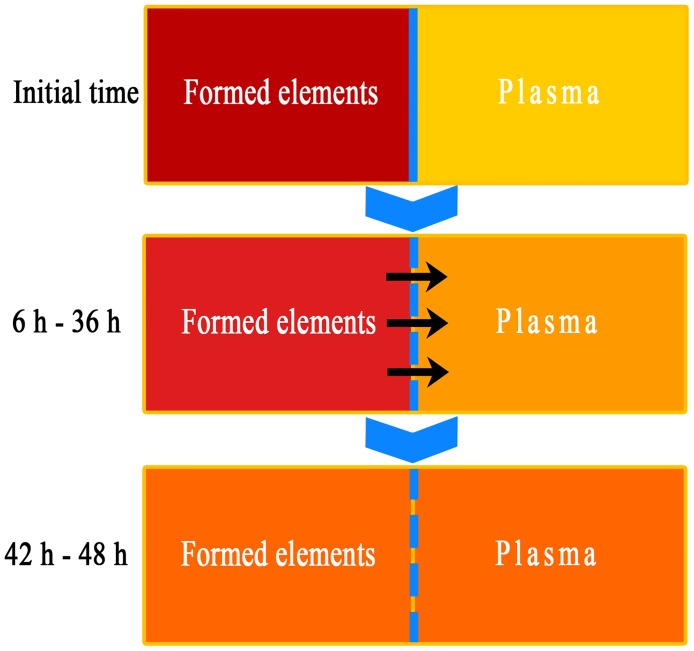
Order and degree of postmortem changes in blood after death as time progresses.The blue lines represent cell membranes (solid lines: intact; dotted line: broken-down), and the black arrows represent the effects of redistribution.